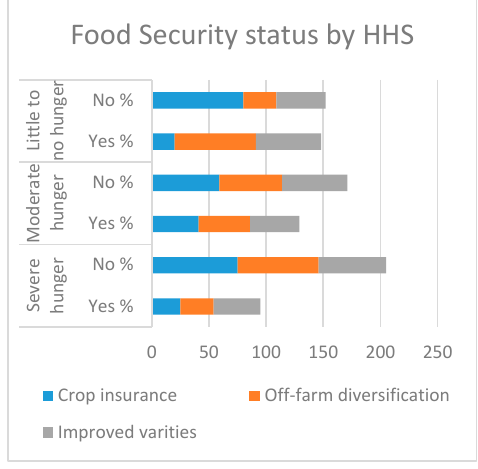
Figure 6. Household hunger status.